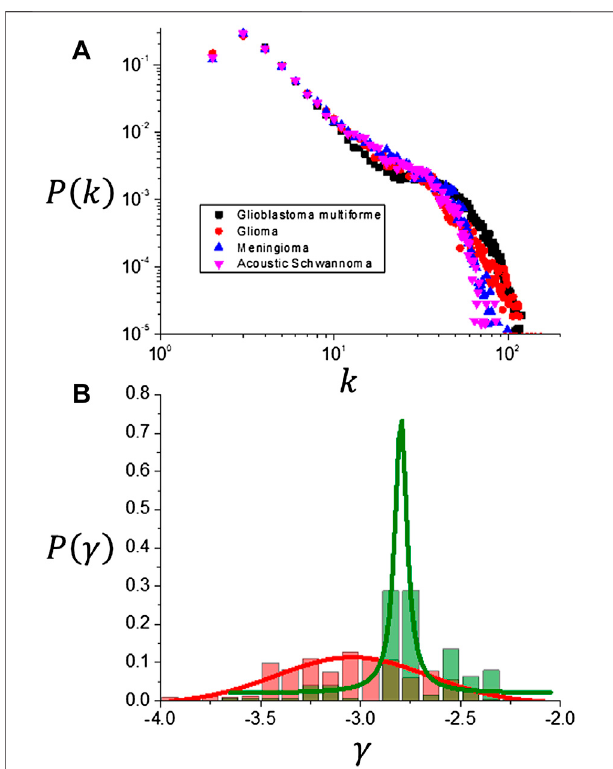
FIGURE 11 | (A) Visibility graph degree distributions P ( k ) for different tumor types. A power law behavior region is observed for k < 20 and the probability decreases abruptly beyond that value. (B) Frequency distributions for the exponent γ of the power law behavior.